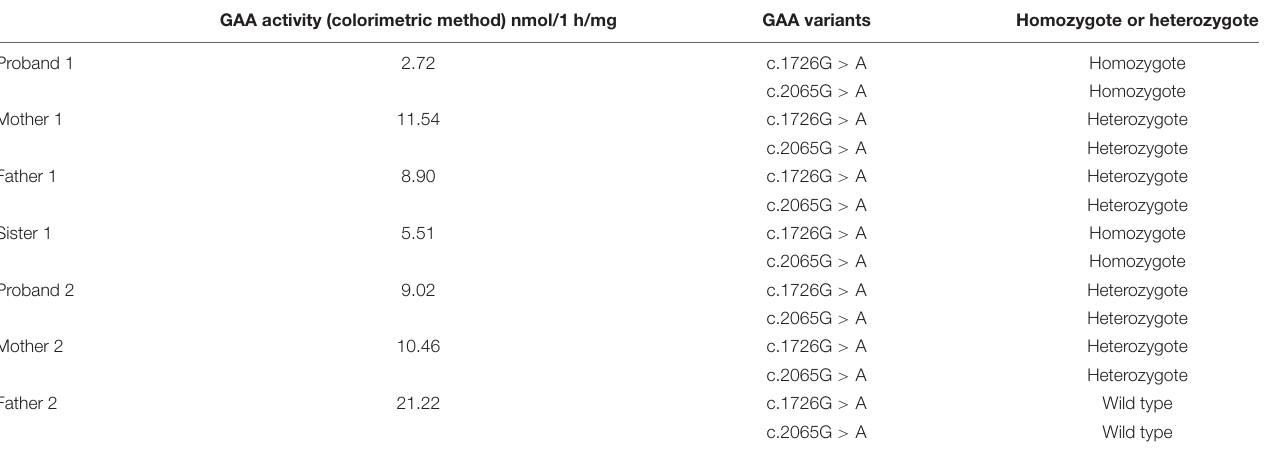
FIGURE 1 | Duchenne muscular dystrophy DMD gene sequencing for the patients and their lineal relatives. (A) Result of DMD gene sequencing in case 1. (B) Result of DMD gene sequencing in case 2. TABLE 1 | Comparison of acidic α -glucosidase (GAA) activity and GAA variants between probands and their